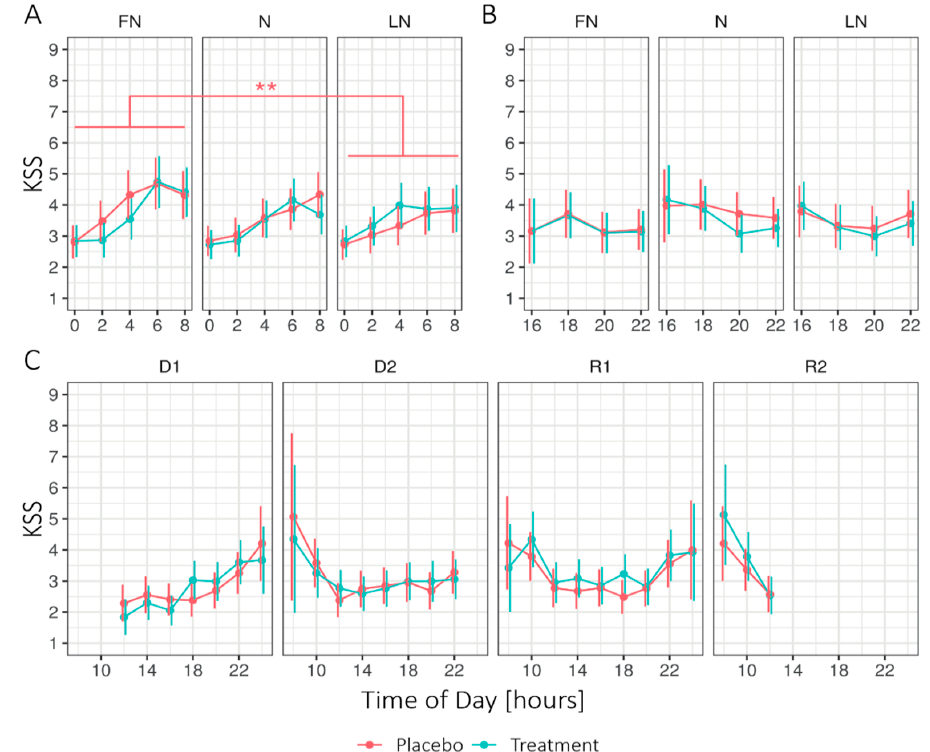
Figure 1. Estimated marginal means for the Karolinska Sleepiness Scale (KSS) in 2-h intervals, ( A ) during nightshift work, ( B ) after nightshift work, and ( C ) on the first two days and recovery days for the treatment and placebo condition. Higher values indicate higher levels of sleepiness. Error bars indicate the 95% confidence intervals of the estimated marginal means. D1 = first day before nightshift, D2 = second day before nightshift, FN = first night of nightshift, N = nightshift, LN = last night of nightshift, R1 = first recovery day, and R2 = second recovery day. For all time periods, Conditions did not significantly di ff er per day. Note that significant e ff ects at the level of Time of day are not displayed. ** = p < 0.01.